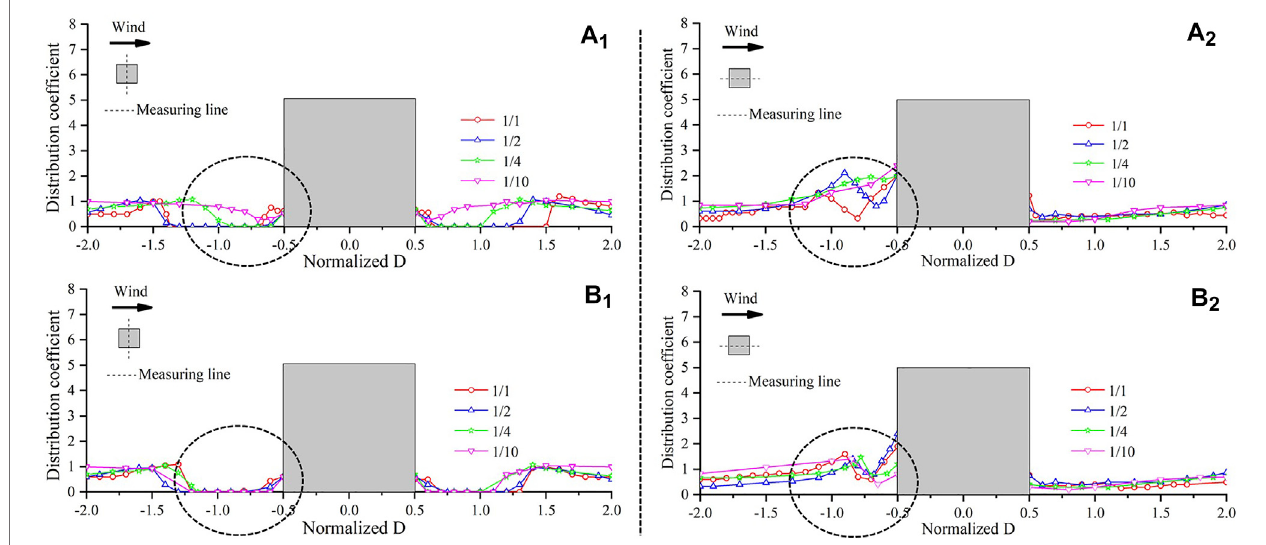
FIGURE 7 | Comparison of the normalized snow depth of experiments using two different similarity criteria. (A1, B1) based on the densimetric Froude number similarity criteria and (A2, B2) based on the new Froude number similarity criteria proposed in this paper.